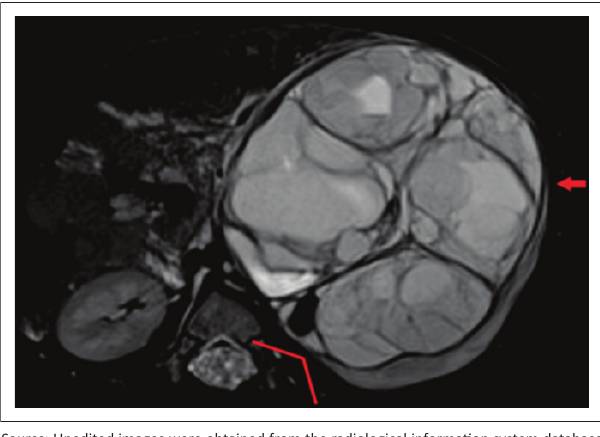
Source : Unedited images were obtained from the radiological information system database (RIS) of Tygerberg hospital while editing and markers seen were added by the author. FIGURE 3: Axial fat-suppressed T2-weighted magnetic resonance image of a large cystic nephroblastoma arising from the left kidney. The claw sign is positive with tapering (red arrow), absent infolding and obtuse external kidney–tumour interface (red marker).